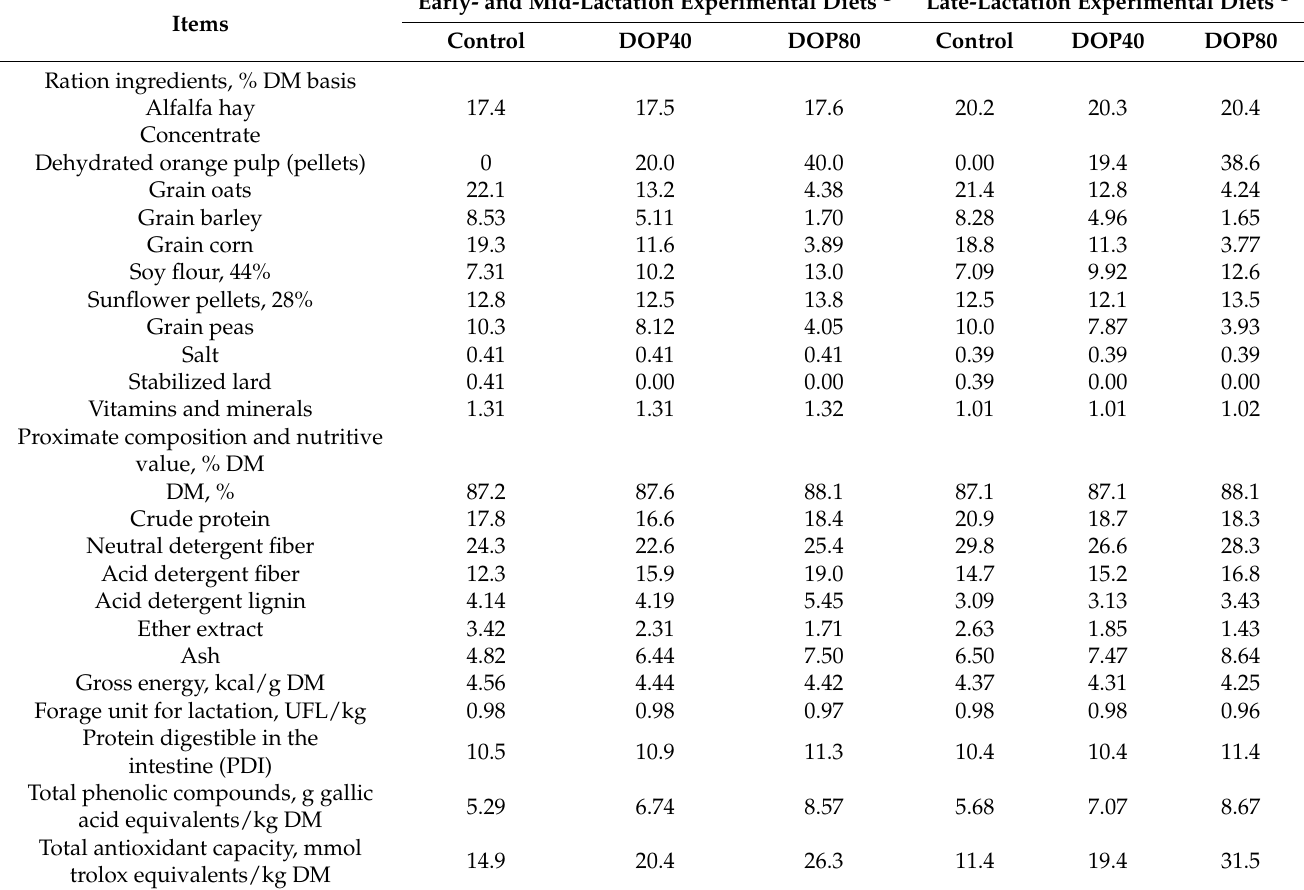
Table 1. Ration ingredients and proximate and fatty acid (FA) composition of the experimental diets throughout the lactation